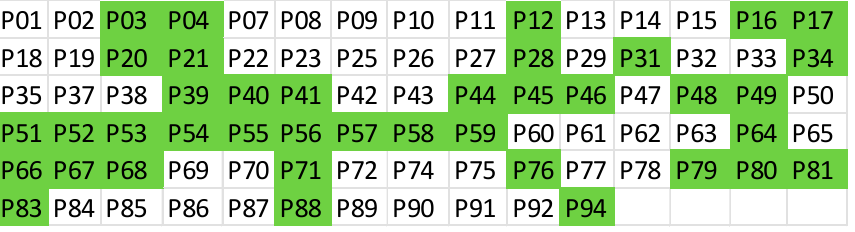
Figure 6. Selected lines (Green Color) to potentially be replaced for p m1 = 5%.